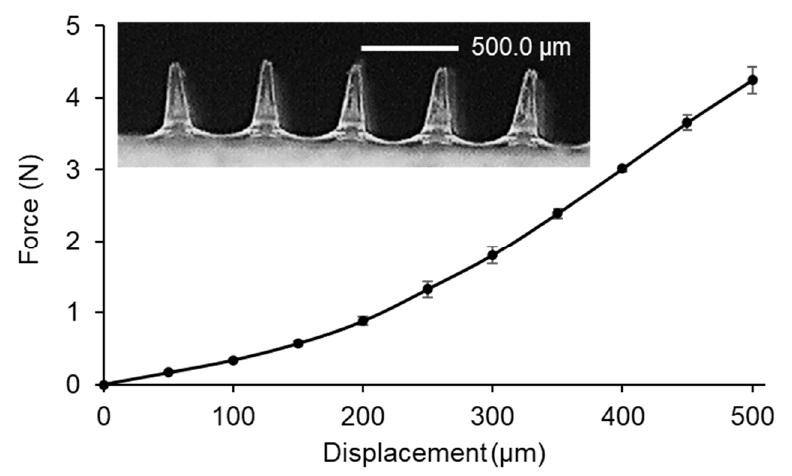
Figure 4. Force-displacement curve from mechanical strength test of hydrogel-forming MNs. To study in vitro recovery of the extracted ISF extraction, the calibration curve of methylene blue in ISF was established in the range of 0.3125–5 µ g/mL. The linear